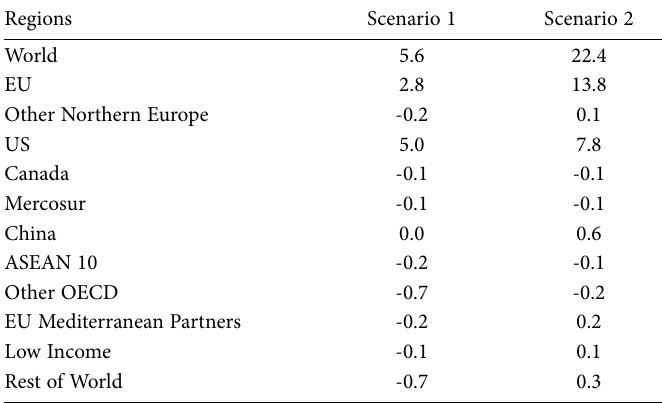
Table 5. Changes in welfare [Billion USD].